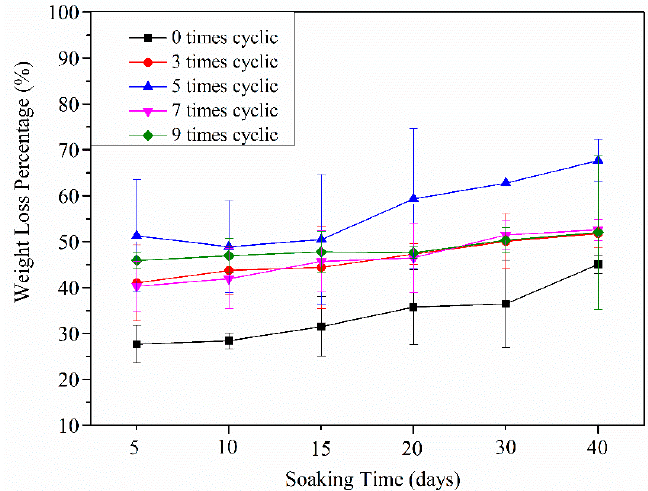
Figure 10. The degradation rate of the CDs 3.0 / HA 0.6 / PVA DN hydrogels with 0, 3, 5, 7, and 9 freezing-thawing cycles after soaking in the fetal calf serum solution for 5, 10, 15, 20, 30, or 40